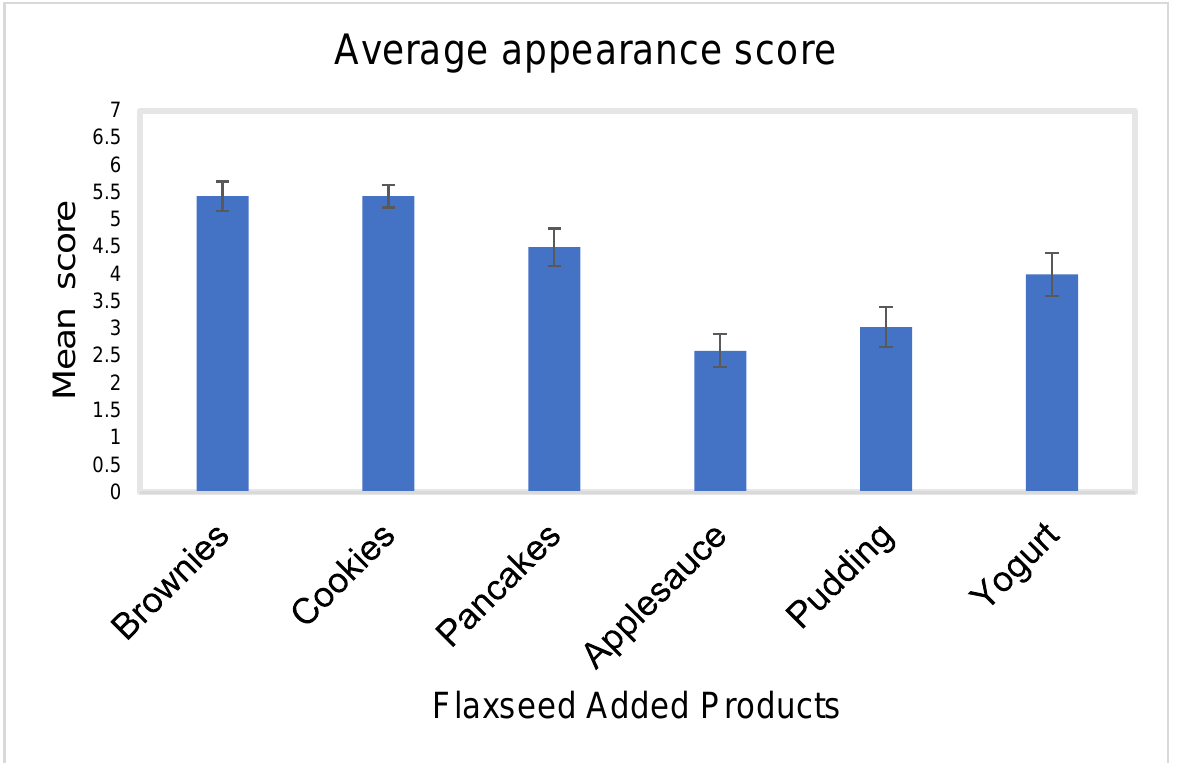
Figure 1. Bar chart showing the mean appearance score for all flaxseed products with standard errors of mean (SEMs).